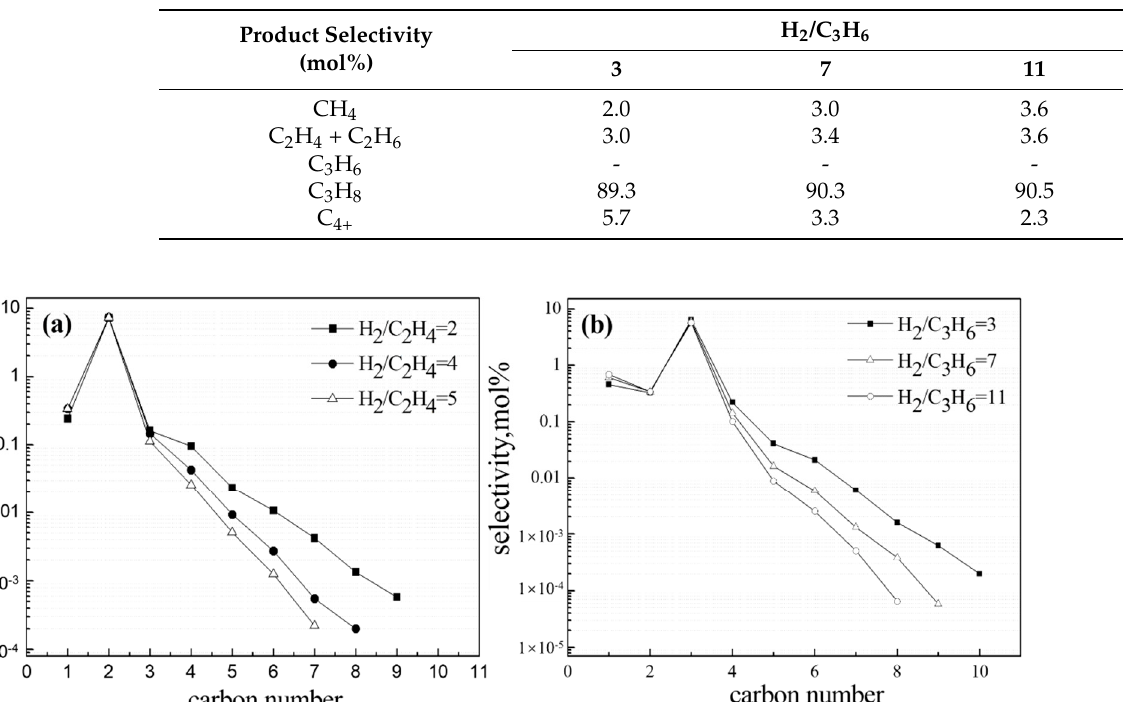
Table 2. C 3 H 6 reaction in H 2 atmosphere (T = 533 K, p = 0.8 MPa).